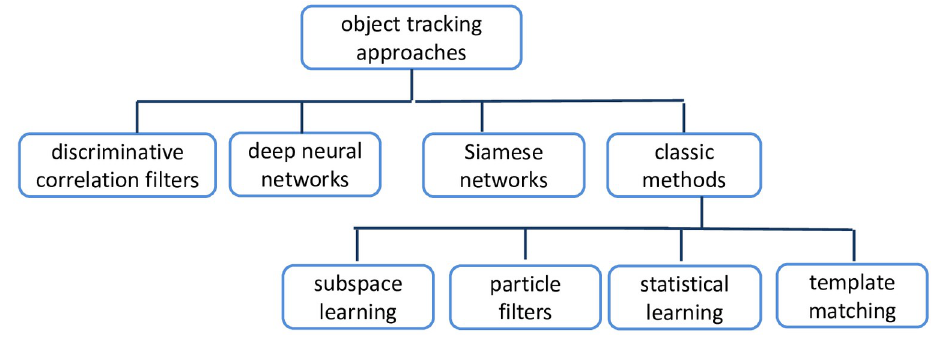
Fig 1. A taxonomy of object tracking